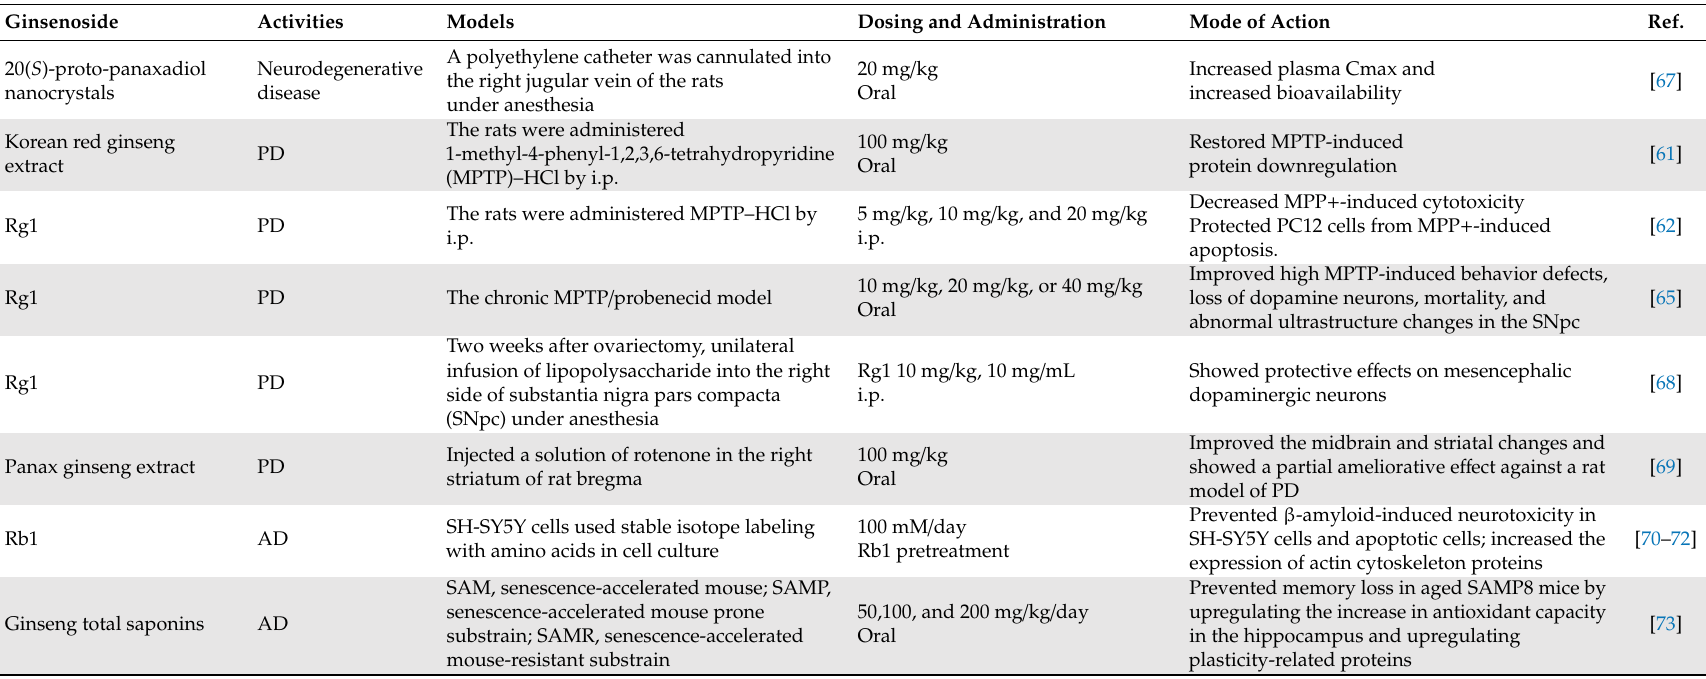
Table 1. Summary of the treatment of ginsenosides in Parkinson’s disease (PD) and Alzheimer’s disease